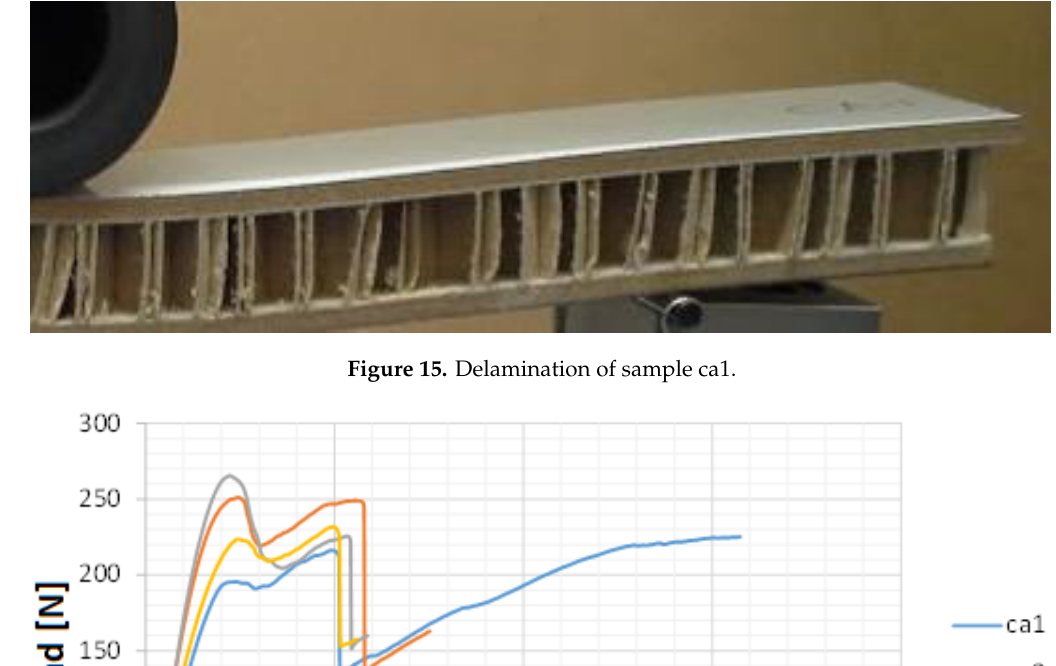
Figure 14. Bending test of sample ca1.